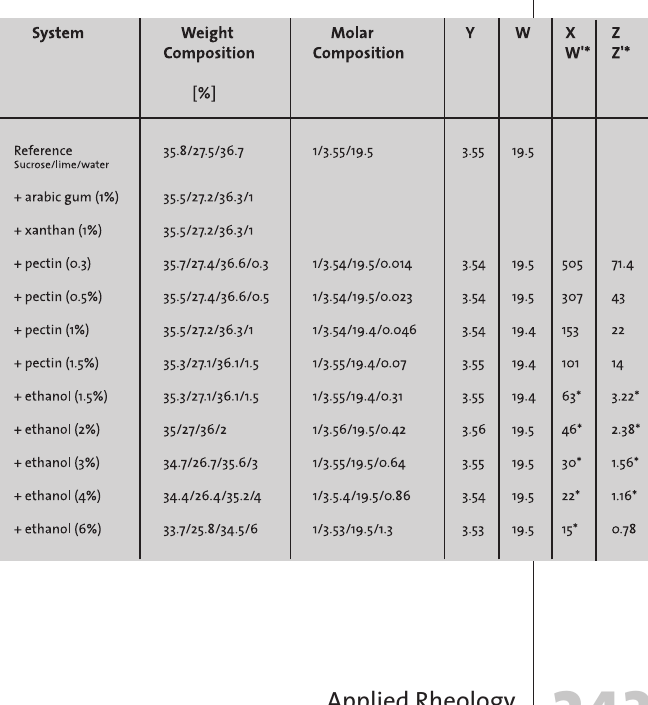
Figure 7 (left): Spectromechanical results (G’ ( Á , Ê ), G” ( É , ü )) for a.) the reference system and b.) the reference system + 1 % pectin. Figure 8 (right above): Variations of plateau modu- lus G N ( Ê ) and characteristic angular frequency w 0 ( ü ) versus pectin weight per- centage. Figure 9 (right below): Variations of the slopes dlog G’ / dlog w ( Ï ) and dlog G’’ / dlog w ( ü ) versus pectin weight percentage. Table 4 (bottom): Compositions of the differ- ent studied systems: Y repre- sents the molar ratio [lime]/[sucrose], W is the molar ratio [water}/[sucrose]. These two ratios are constant for all the mixtures. Systems con- taining pectins: X is the mo- lar ratio 2[Ca2+]/[COO-]or 2[Ca2+]/[pectin] and Z is the molar ratio [sucrose]/[pectin]. Systems containing ethanol: W’ is the molar ratio [water]/[ethanol] and Z’ the molar ratio